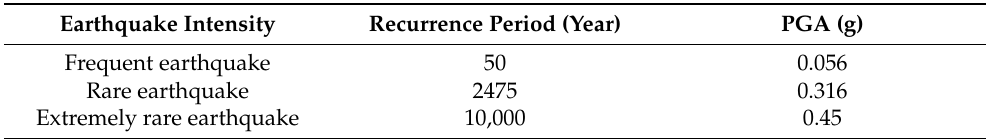
Figure 4. Spectral characteristics of the selected ground motions: ( a ) each response spectrum and target response spectrum; ( b ) mean response spectrum and target response spectrum. Table 8. Earthquake recurrence periods and corresponding PGAs when the PGA of moderate earthquake intensity is 0.15